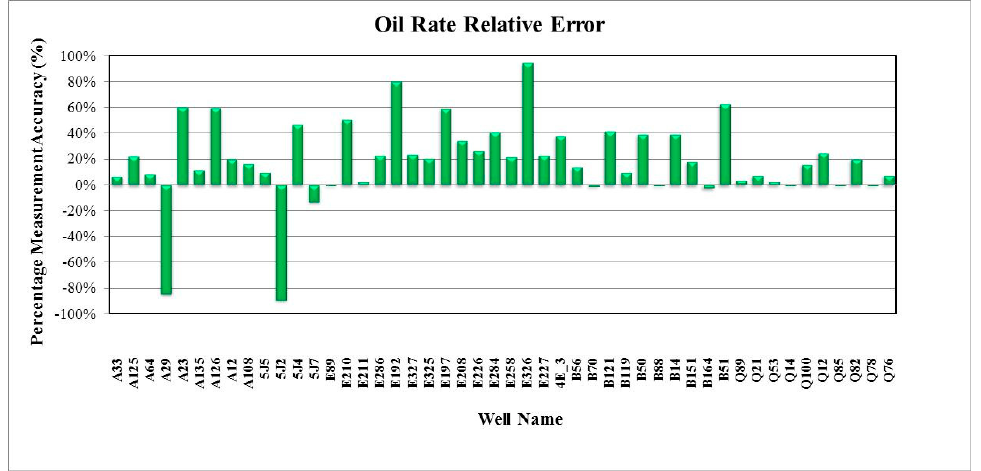
Figure 21. Water rate measurement accuracy using the Darcy correlation.